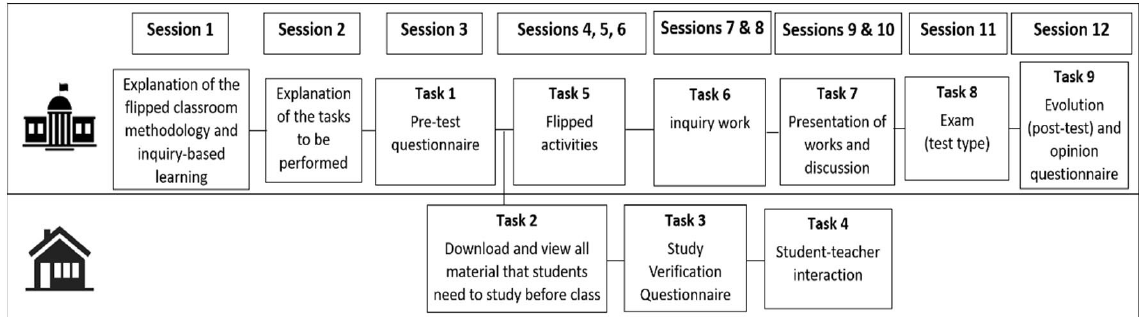
Figure 1. Design of the classroom experience implemented with students of 1st Baccalaureate on anatomy and pathophysiology of the digestive